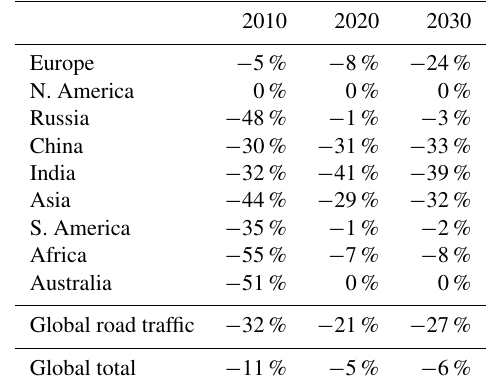
Table 2. The relative change in annual road transport PN emissions in comparison to the CLE scenario, if (in addition to the technolog- ical advancements described in the CLE scenario) all the diesel fuel (consumed in road transport) is assumed to be replaced with ultra- low sulphur content–fuel (FSC = 10ppm). The lowest row shows the change in total emissions from all sources. Note that, e.g. in Eu- rope, the impact increases with time, because in the CLE scenario the emissions decrease drastically in most countries, but a small share of high FSC fuel remains present in some (non-EU) countries. Thus, the proportion of the high FSC contribution to total emissions in the CLE scenario increases with